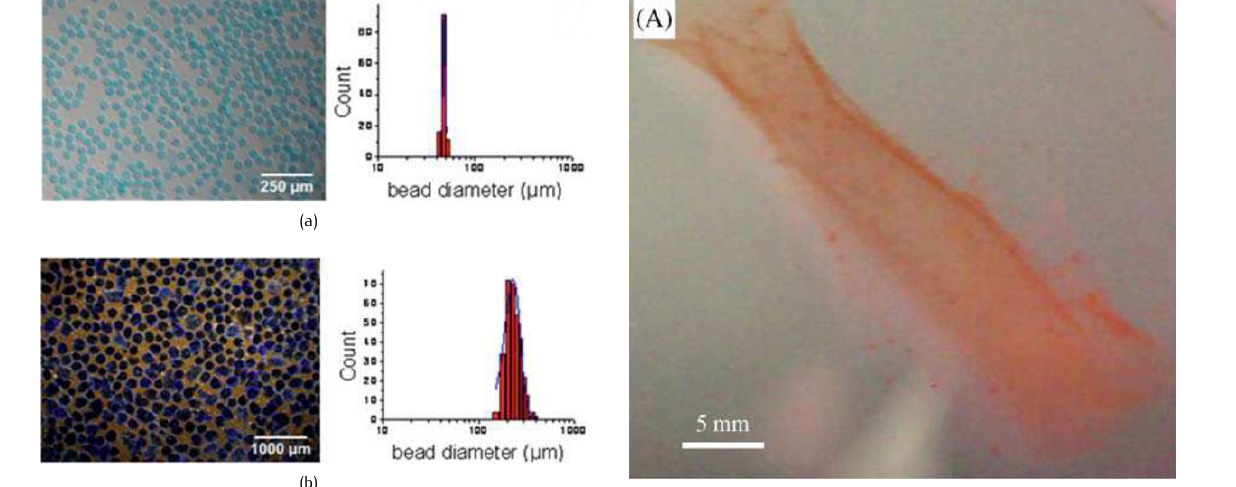
Figure 4. Photographyof a3Dstructurefabricatedwith fibrinbyinkjet printing cultured in medium at day 1. The gross dimension of the 3D structure was 25 mm × 5 mm × 1 mm